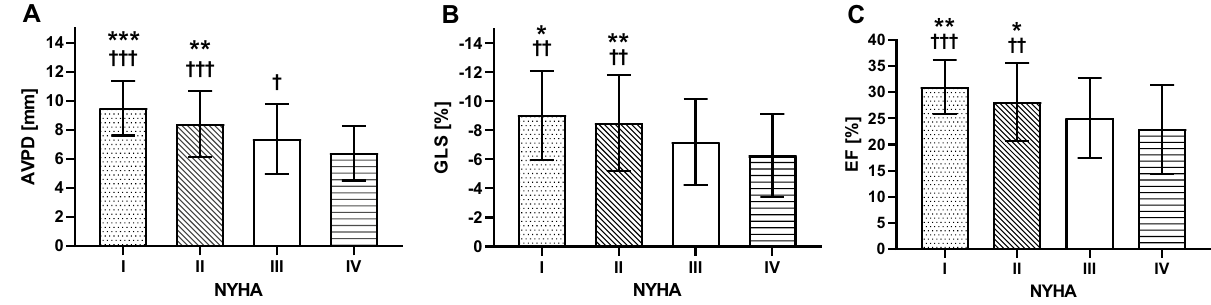
Figure 1. Ventricular function vs NYHA classification. ( A ) Atrioventricular plane displacement (AVPD); ( B ) global longitudinal strain (GLS); and ( C ) ejection fraction (EF) values stratified by New York Heart Association (NYHA) classes. There are stepwise reductions in AVPD, GLS and EF with increasing NYHA class and AVPD was the only variable that significantly differed between NYHA III and IV. Bars and whiskers represent means and standard deviations. *p < 0.05 vs NYHA III, **p < 0.01 vs NYHA III, ***p < 0.001 vs NYHA III, † p < 0.05 vs